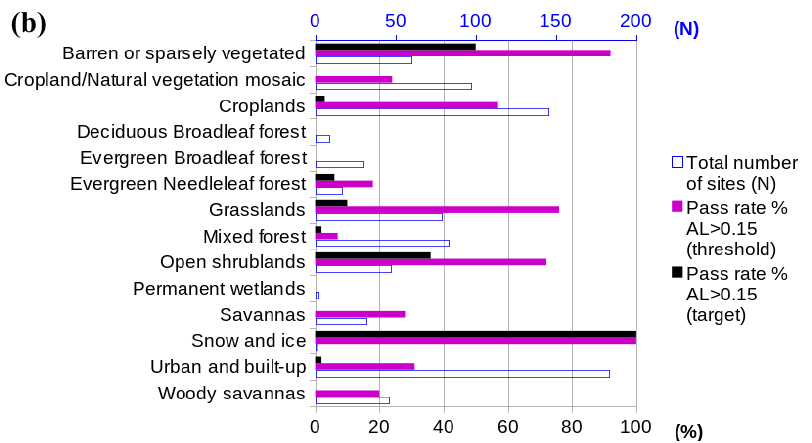
Figure 9. Pass rate for VGT per land cover type using the MODIS Land Cover product and MODIS as a reference. Results are given for the two regimes of surface albedo values: ( a ) Lower than 0.15; and ( b ) greater than 0.15. ‘Threshold’ and ‘Target’ levels of requirements are indicated in Table 5.